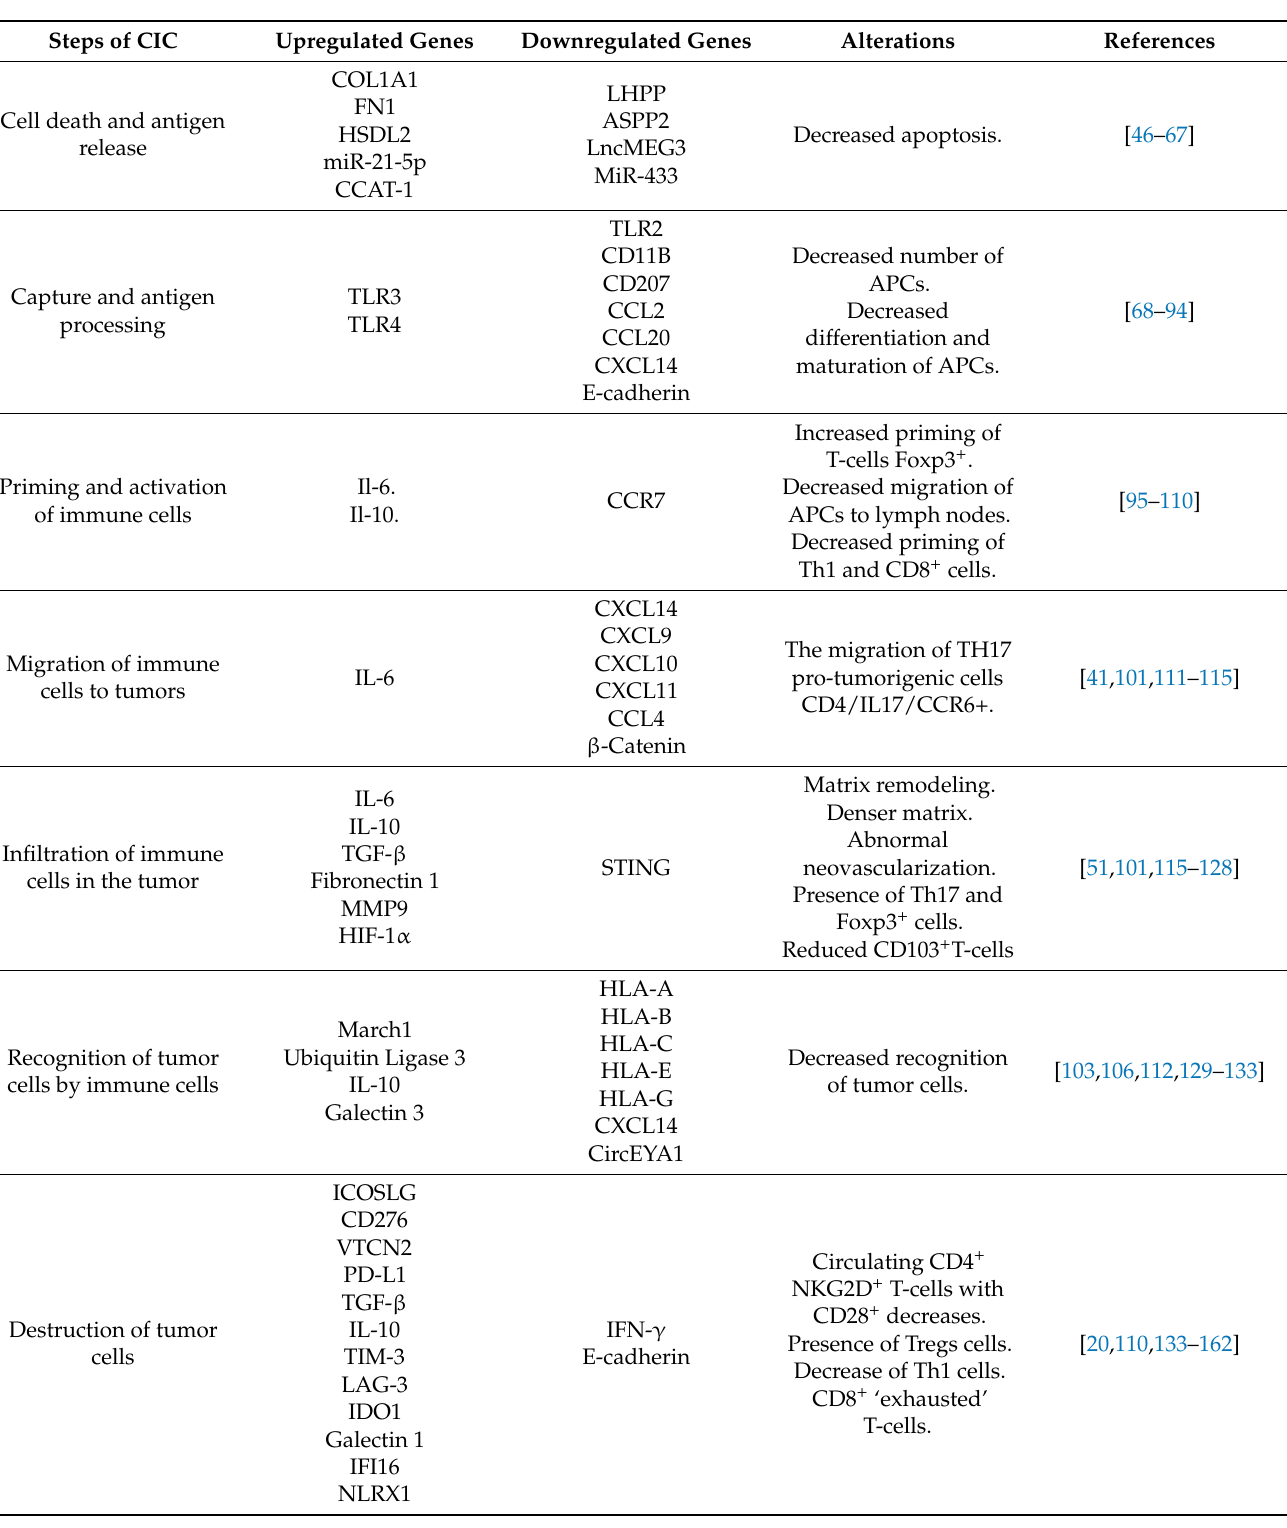
Table 1. Potential therapeutic targets in the cervical cancer-immunity cycle. Description of the main changes found in each of the stages in the cervical cancer-immunity